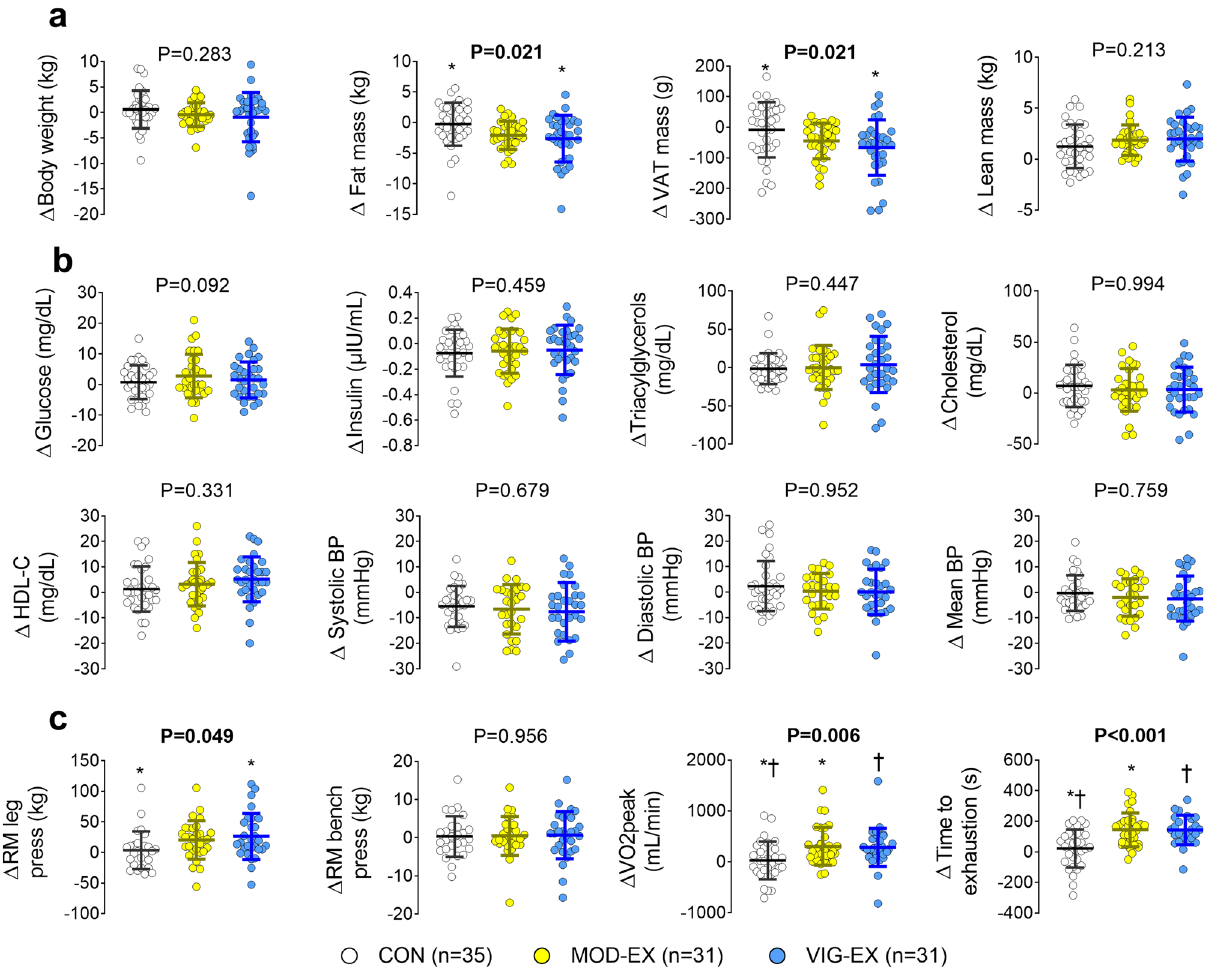
Fig. 4 | Effect of the 24-week supervised exercise intervention on secondary endpoints. a Body weight and composition parameters, b cardiometabolic risk factors, and c physical fi tness parameters. Δ was calculated as post-intervention minus baseline value for every outcome. Serum concentrations were log 10 trans- formed. P values are from analyses of covariance (ANCOVAs), adjusting for base- line values. * and † indicate signi fi cant differences between pairs after Bonferroni